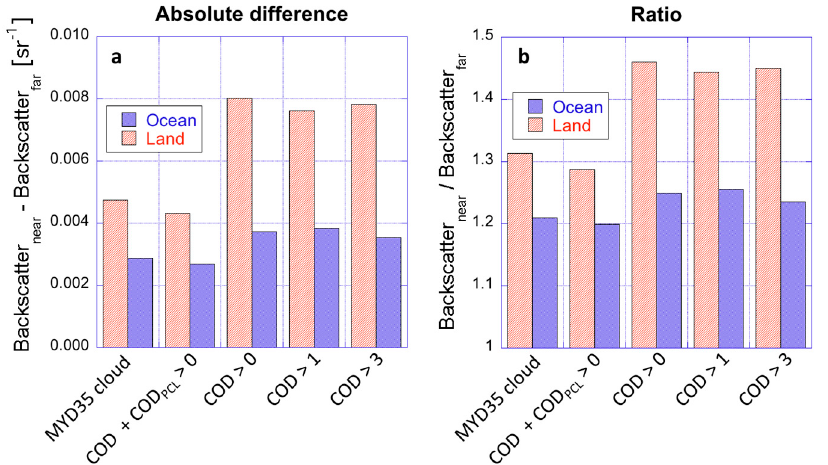
Figure 2. Differences between mean vertically integrated lidar backscatters of the closer-to-cloud and farther-from-cloud halves of all clear pixels, plotted separately for 5 different criteria used for identifying nearby clouds. ( a ) Absolute difference; ( b ) Ratio. MYD35 is the MODIS operational cloud mask, COD and COD PCL are the cloud optical depths of overcast and partly cloudy pixels, respectively. Data used for generating Figure are available at Table S1.